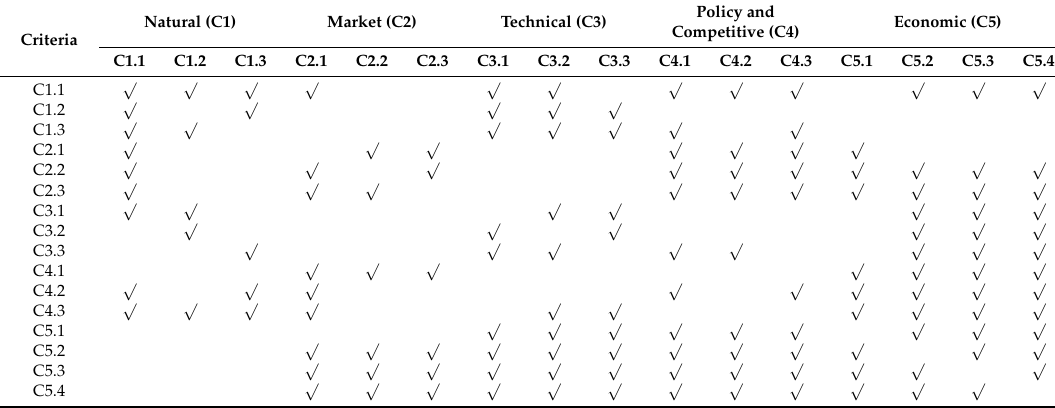
Table 4. Mutual influence concerns of the